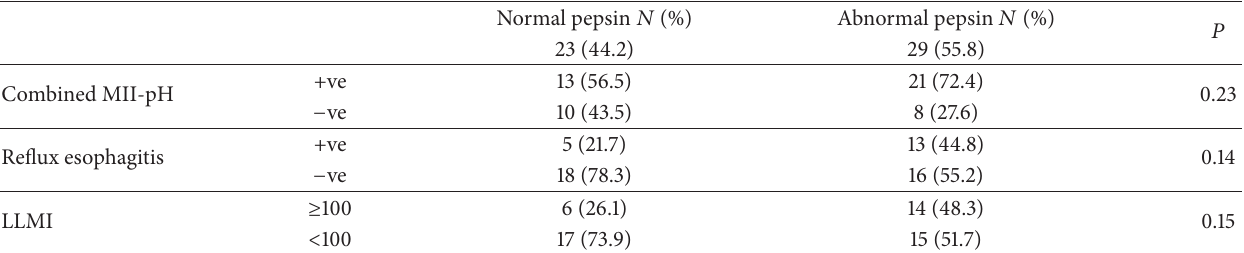
Table 4: Relation between BAL pepsin and GERD diagnostic tests.